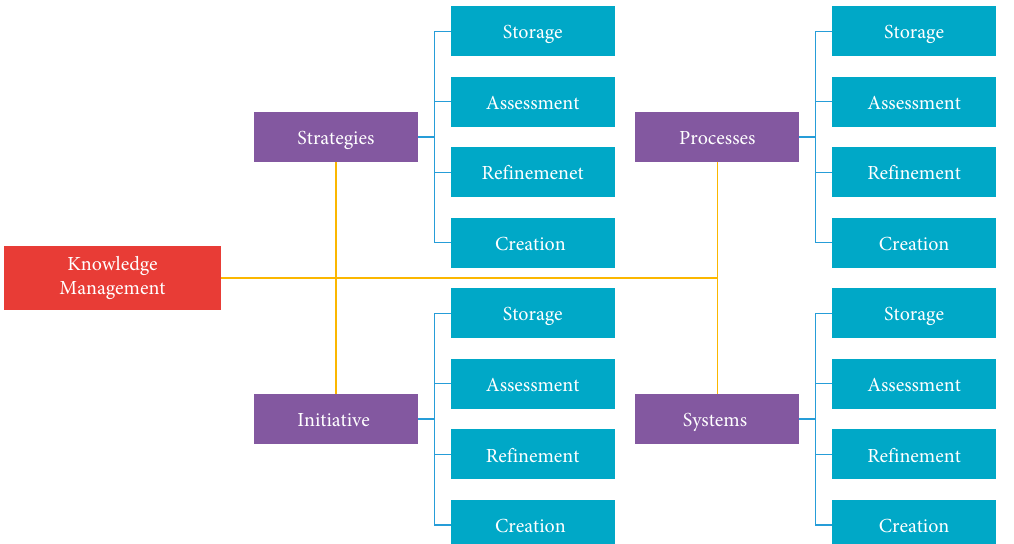
Figure 1: Definition of knowledge management adapted from